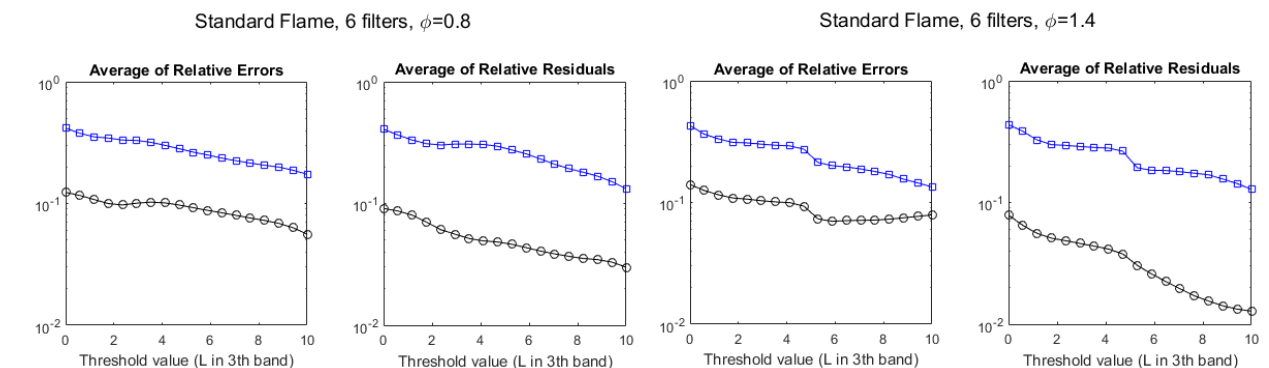
Figure 9. Evolution of the discrepancies between hyperspectral and multispectral temperatures (black circles) and column densities (blue squares), measured as average relative error and average residuals, for the standard flame, as a function of the radiance threshold, measured in W/m 2 · sr · cm − 1 . Left : lean flame ( φ = 0.8). Right : rich flame ( φ = 1.4).